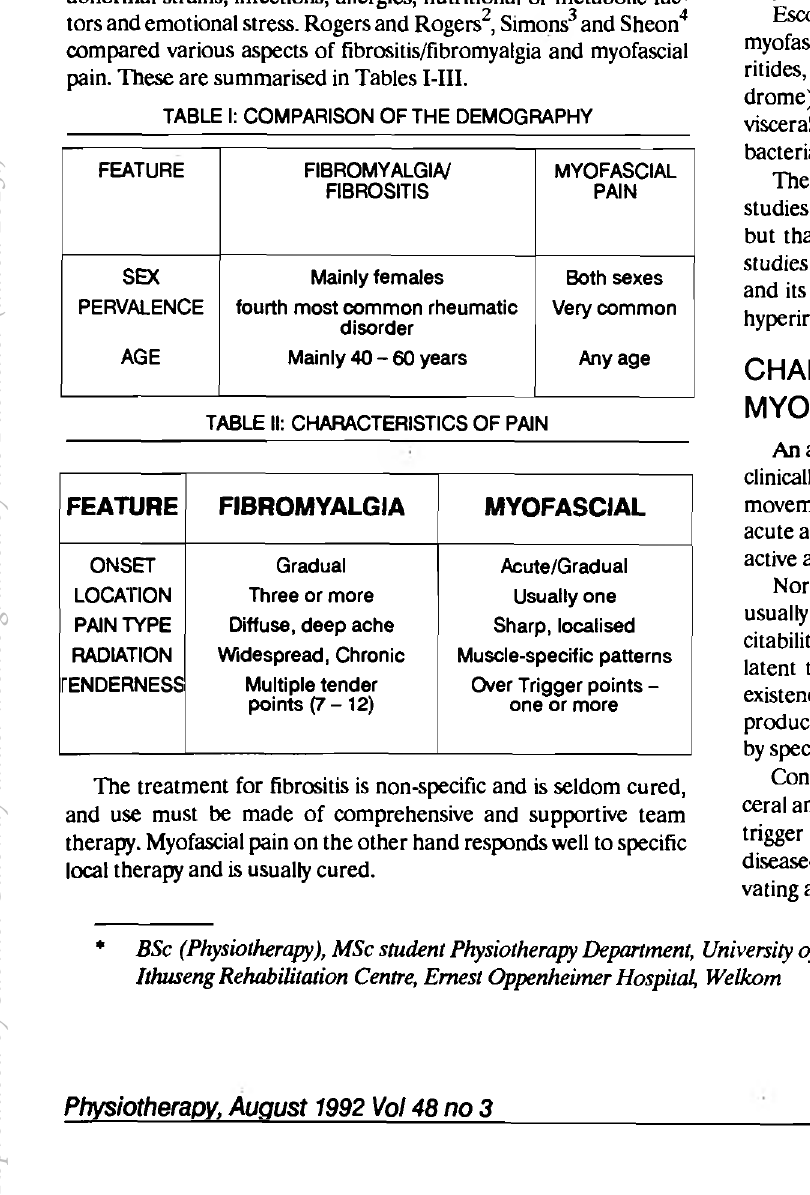
TABLE I: COMPARISON OF THE DEMOGRAPHY